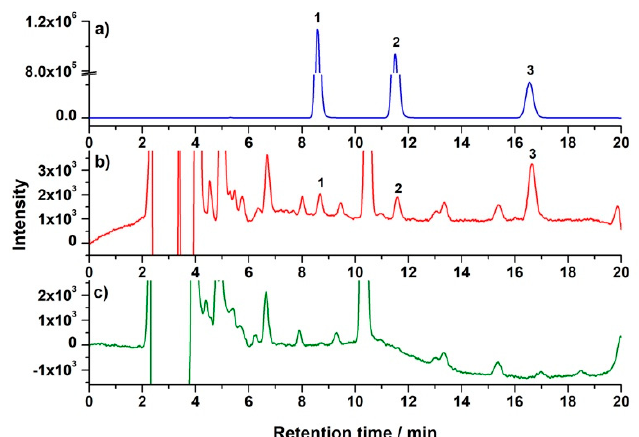
Figure 3. Representative HPLC-fluorescence detector (FLD) chromatograms of ( a ) bisphenol standards, ( b ) spiked bee pollen sample, and ( c ) blank bee pollen sample. Peak 1: bisphenol A (BPA); 2: bisphenol B (BPB); 3: internal standard (IS). The spiked concentrations in ( b ) were 60 μ g/kg and 80 μ g/kg for BPA and BPB, respectively.